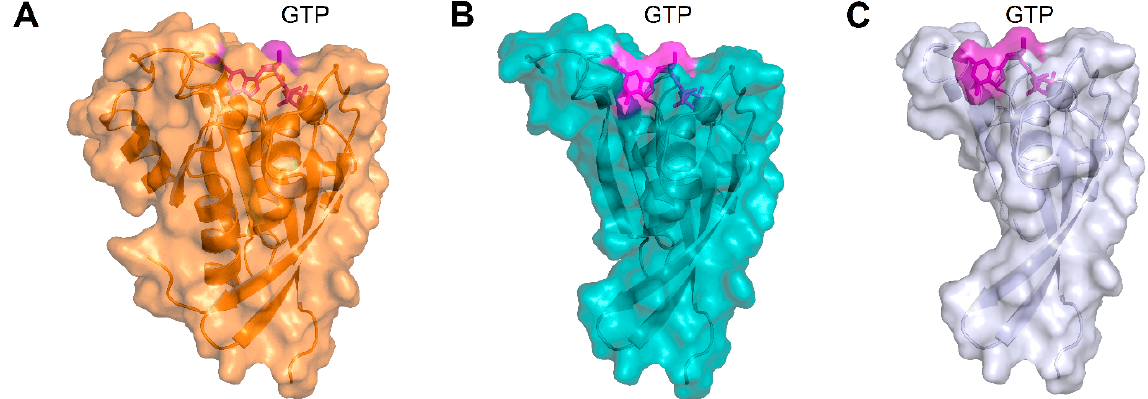
Figure 9. ( A ) Three-dimensional structure of GTP-bound WT Rab-28, protein structure is represented as an orange cartoon, Mg 2+ -ion is shown as an orange sphere, GTP is displayed as magenta sticks, the molecular surface of each element is shown in transparency and colored accordingly. ( B ) Three-dimensional structure of GTP-bound p.(Arg137*) Rab-28, protein structure is represented as a teal cartoon, Mg 2+ -ion is shown as a teal sphere, GTP is displayed as magenta sticks, the molecular surface of each element is shown in transparency and colored accordingly. ( C ) Three-dimensional structure of GTP-bound p.(Trp107*) Rab-28, protein structure is represented as a light blue cartoon, Mg 2+ -ion is shown as a light blue sphere, GTP is displayed as magenta sticks, the molecular surface of each element is shown in transparency and colored accordingly. The GTP molecule shown in panels ( B , C ) is merely for representation purposes, as both truncated forms would not allow the correct folding of the binding pocket.